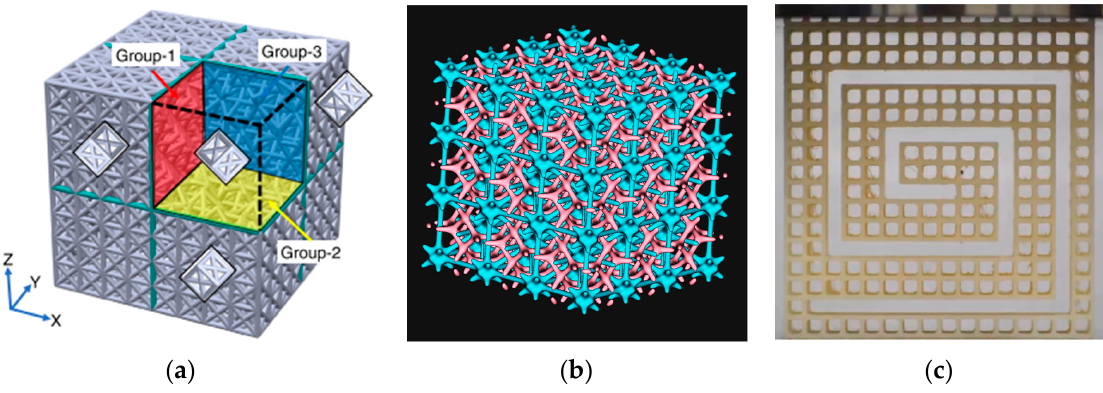
Figure 15. Three examples representing each of the methods for hybridization: ( a ) allocation of differently oriented lattices in different groups, from [34], reproduced under CC BY 4.0 license; ( b ) interpenetrating lattices indicated in different colors; ( c ) deletion of beams within a periodic square grid, reproduced from [33].